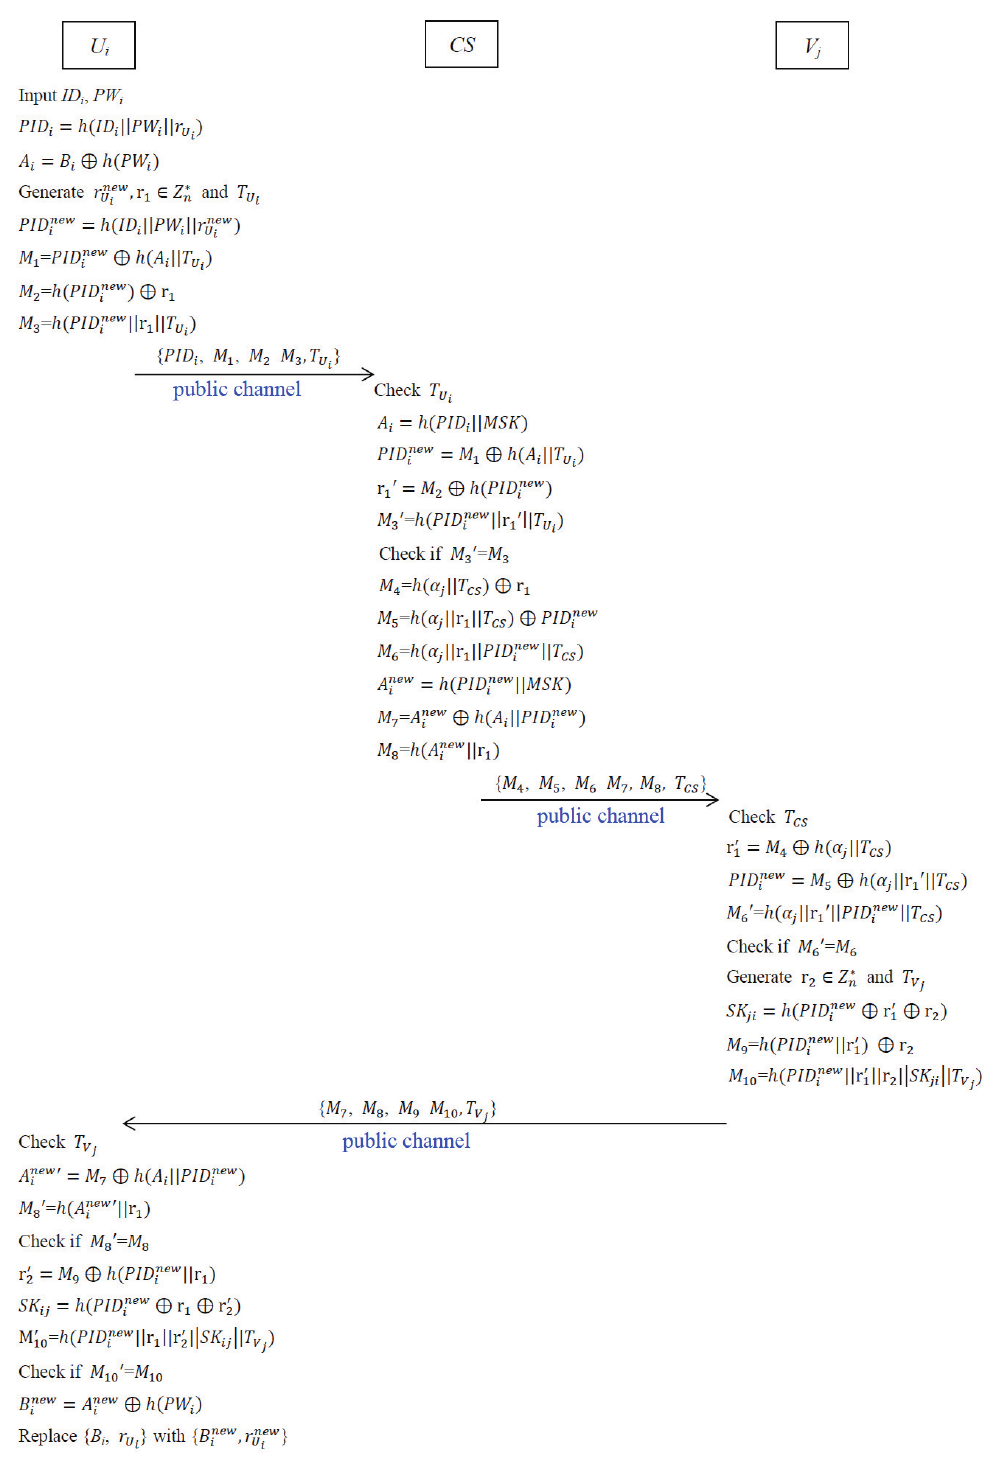
Figure 4. Authentication and key agreement procedure of IoD